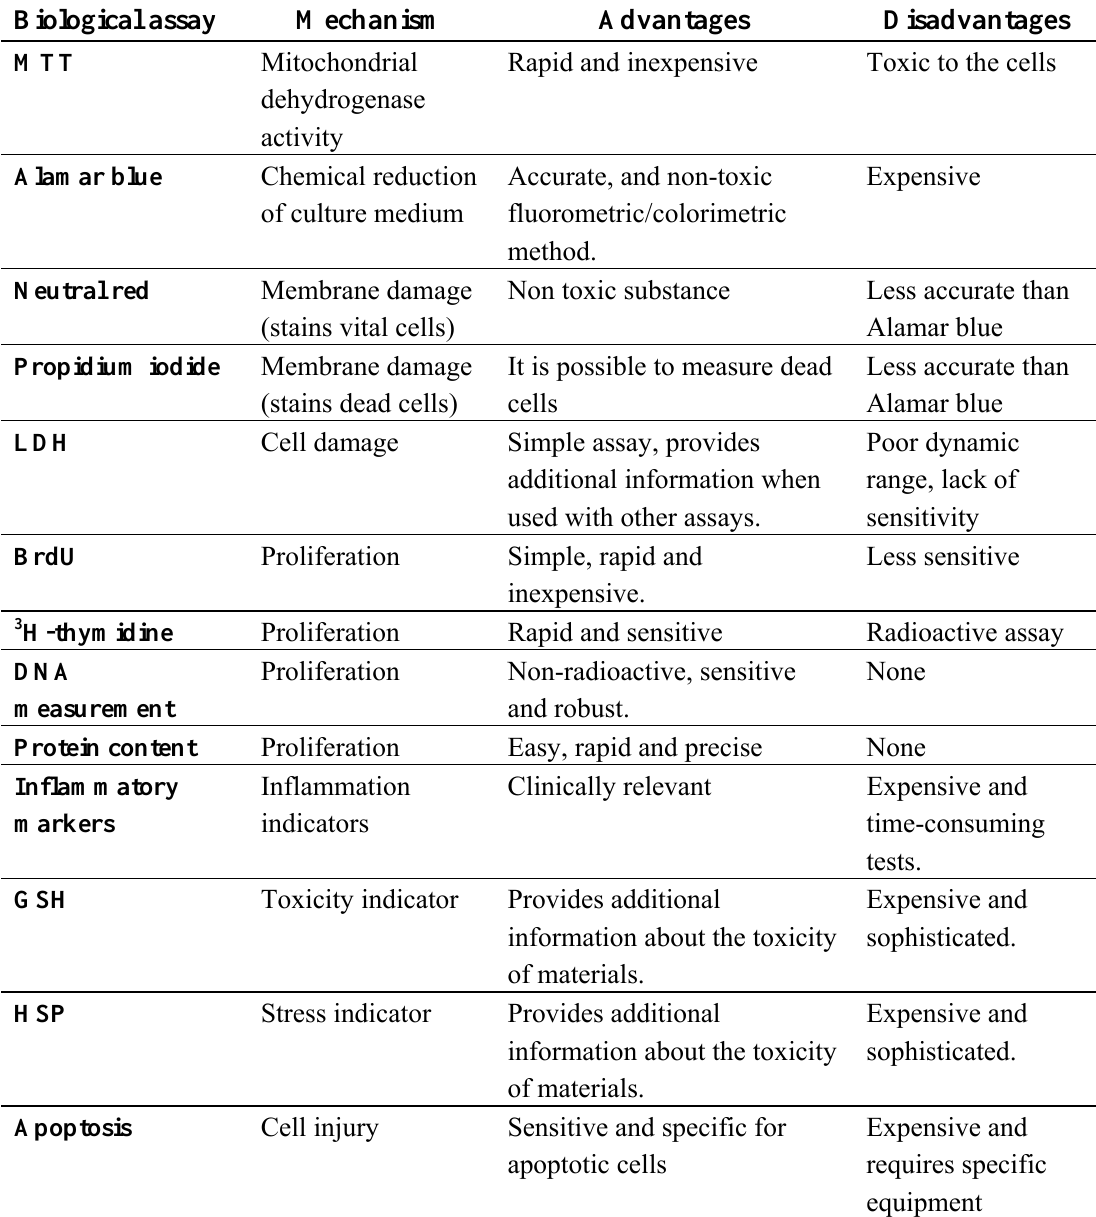
Table 1. Summary of different biological assays used in cytotoxicity